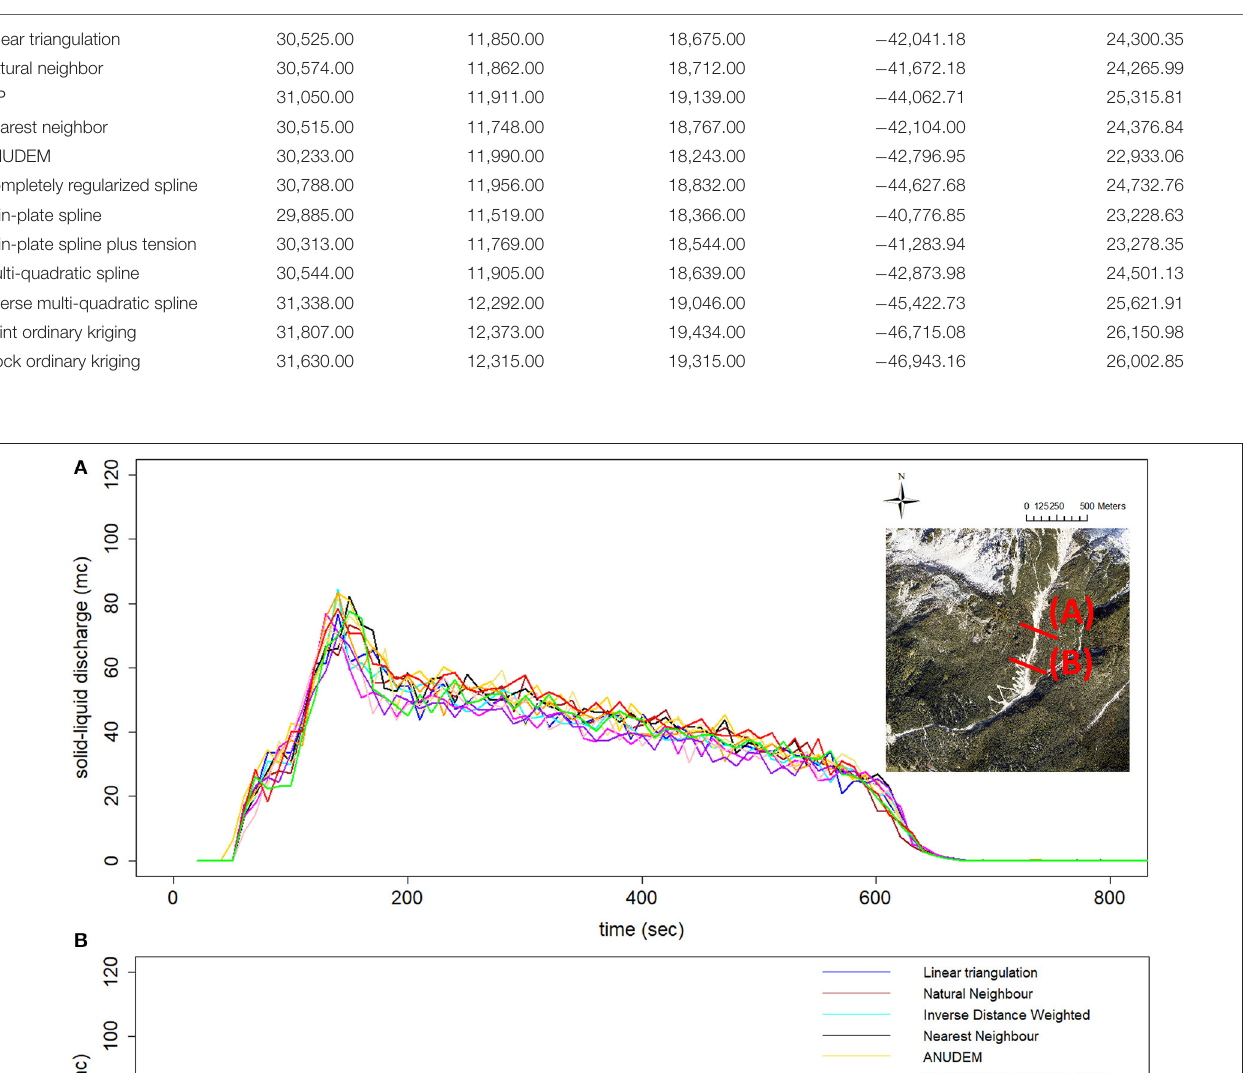
Frontiers in Earth Science |